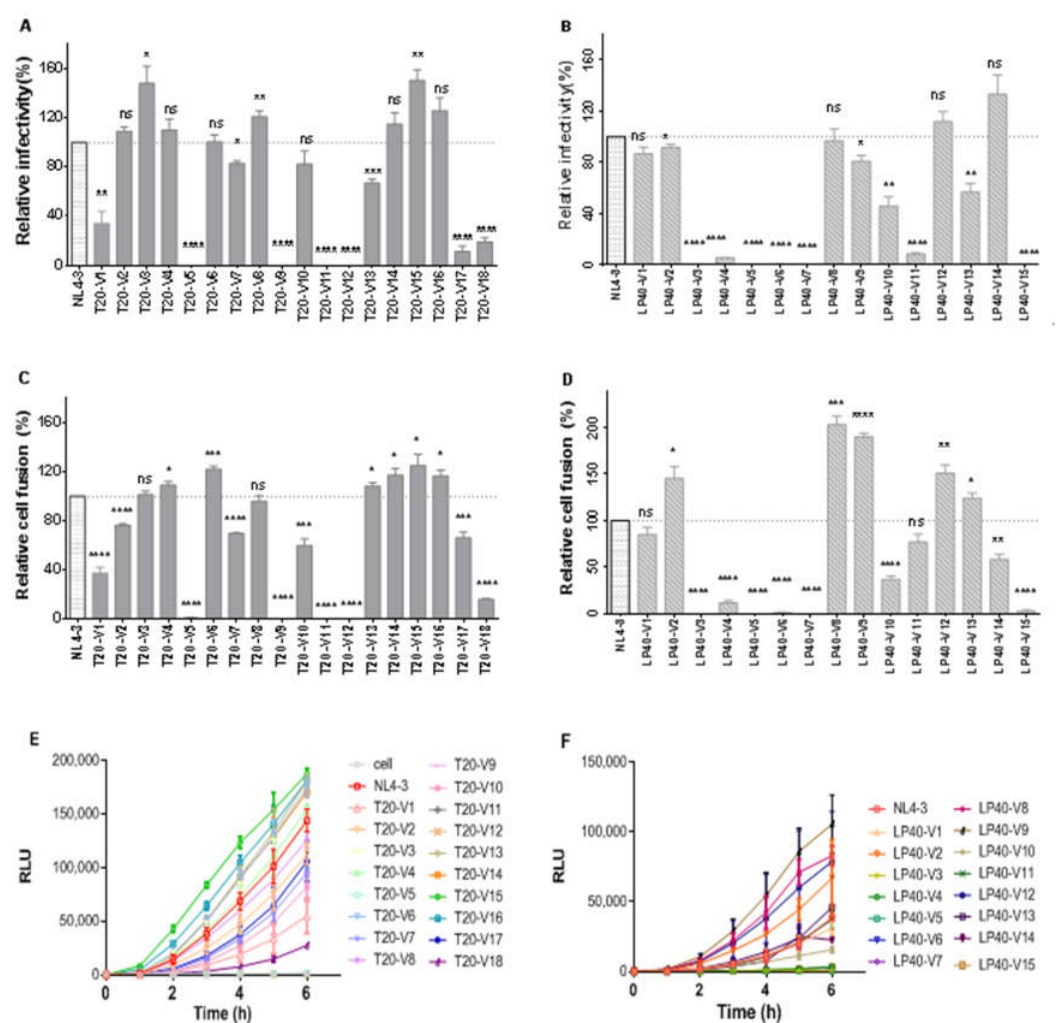
Figure 4. The functional Env profiles of T20- and LP40-resistant mutants. ( A , B ) Relative infectivity of HIV-1NL4-3 and T20- or LP40-resistant mutants, as determined via a single-cycle infection assay. These pseudoviruses were normalized to a fixed amount against P24 antigen, and viral infectivity was tested in TZM-bl cells. The luciferase activity was measured and corrected for background. ( C , D ) HIV-1 mutants’ Env-mediated cell–cell fusion measured using a dual split-protein assay (DSP). For both entry and fusion data, the luciferase activity of wild-type HIV-1NL4-3 (WT) was treated as 100%, and the relative activities of other mutant viruses were calculated accordingly. The experiments of infectivity and fusion were repeated three times, and these data are expressed as means with SD. Statistical comparison was conducted using a t -test, *, p < 0.05; **, p < 0.01; ***, p < 0.001; ****, p < 0.0001; ns, not significant. ( E , F ) Kinetics of HIV-1 Env-mediated cell–cell fusion, determined using a DSP-based assay.